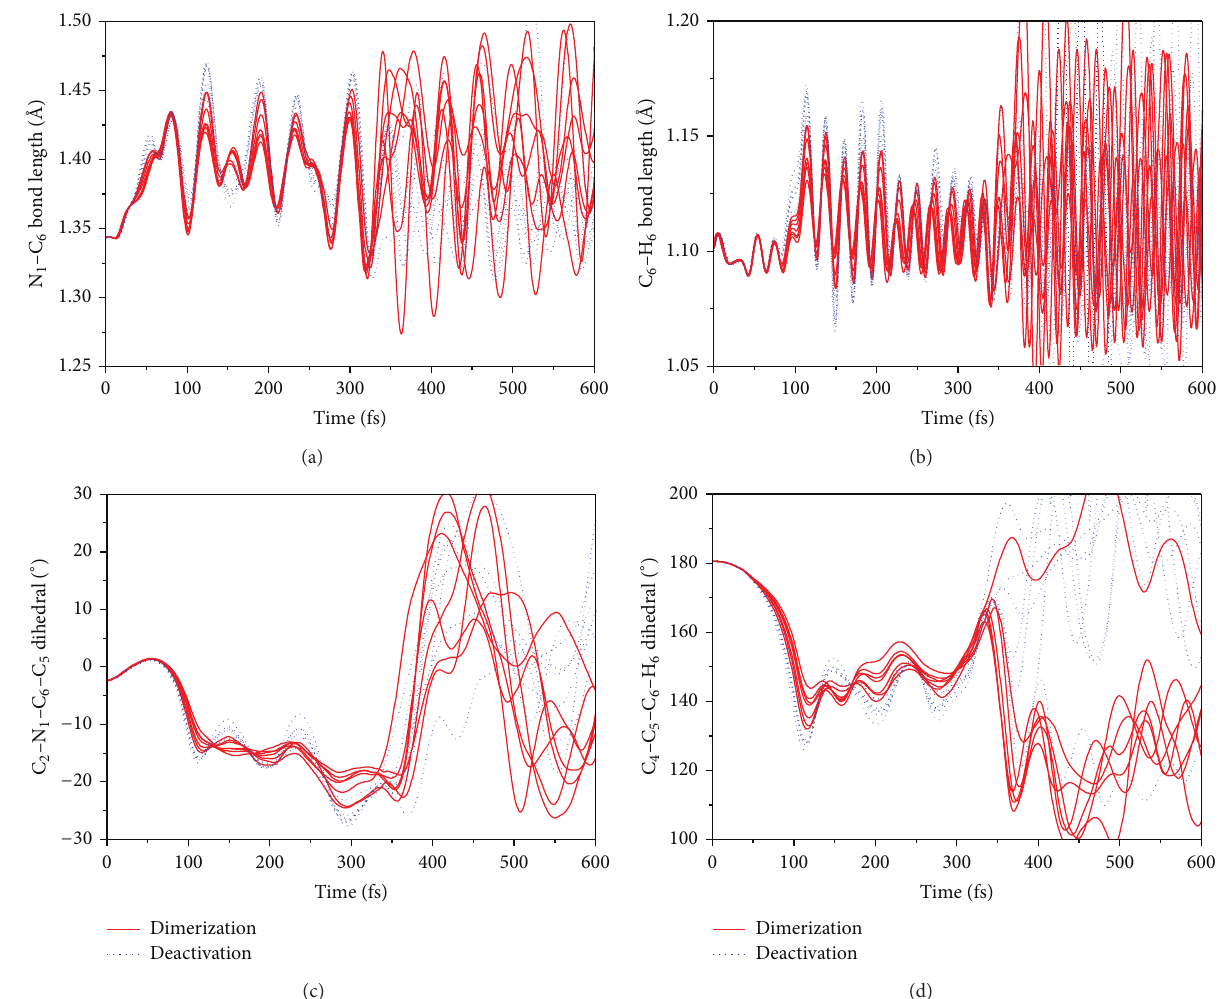
Figure 7: The Variations of some degrees of freedom around C 5 and C 6 atoms of dimerization channels and photophysical deactivation channels. The two channels are simplified as “dimer” and “excimer,”